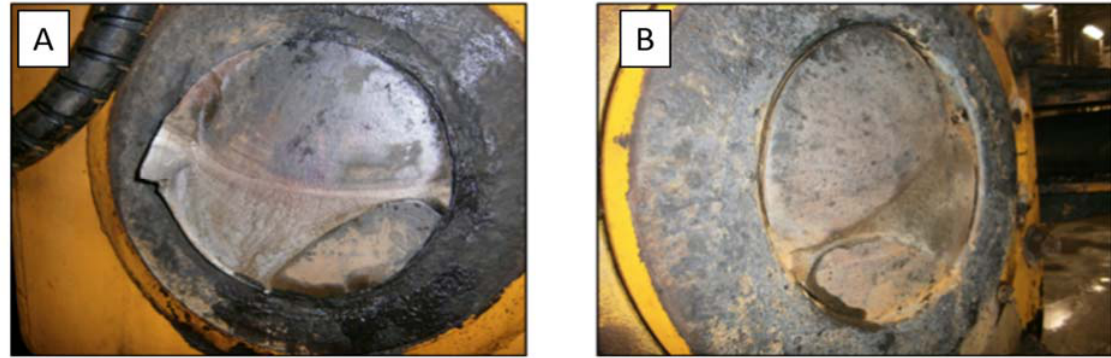
Figure 2. ( A ) Investigated technical object–haul truck, ( B ) typical operating conditions of an underground mine ‐ the haulage route.